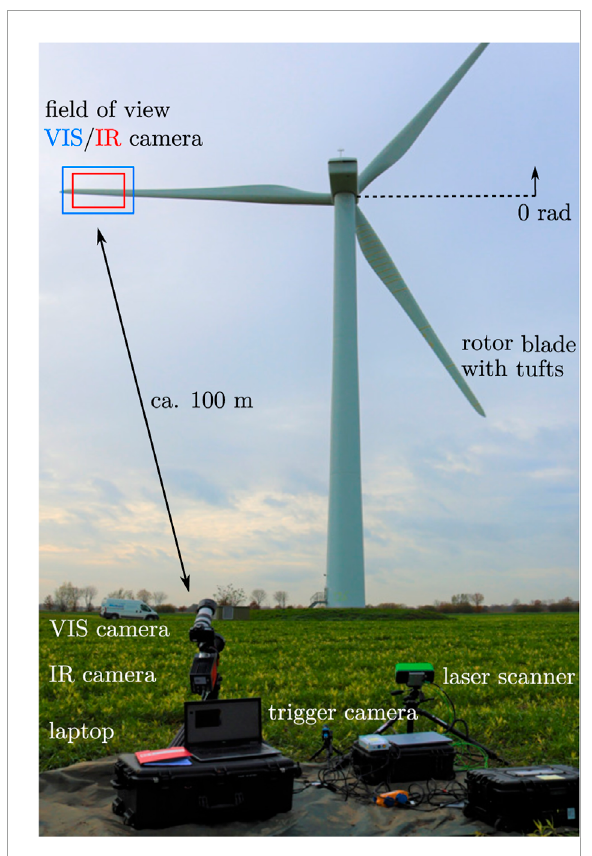
FIGURE 4 An overview of the measurement system for the measurement on the suction side of a wind turbine in operation. The field measurement took place on 14 November 2021, in Thedinghausen, Germany. Note that the orientation of the cameras does not correspond to the field of view respectively the orientation during the measurements.